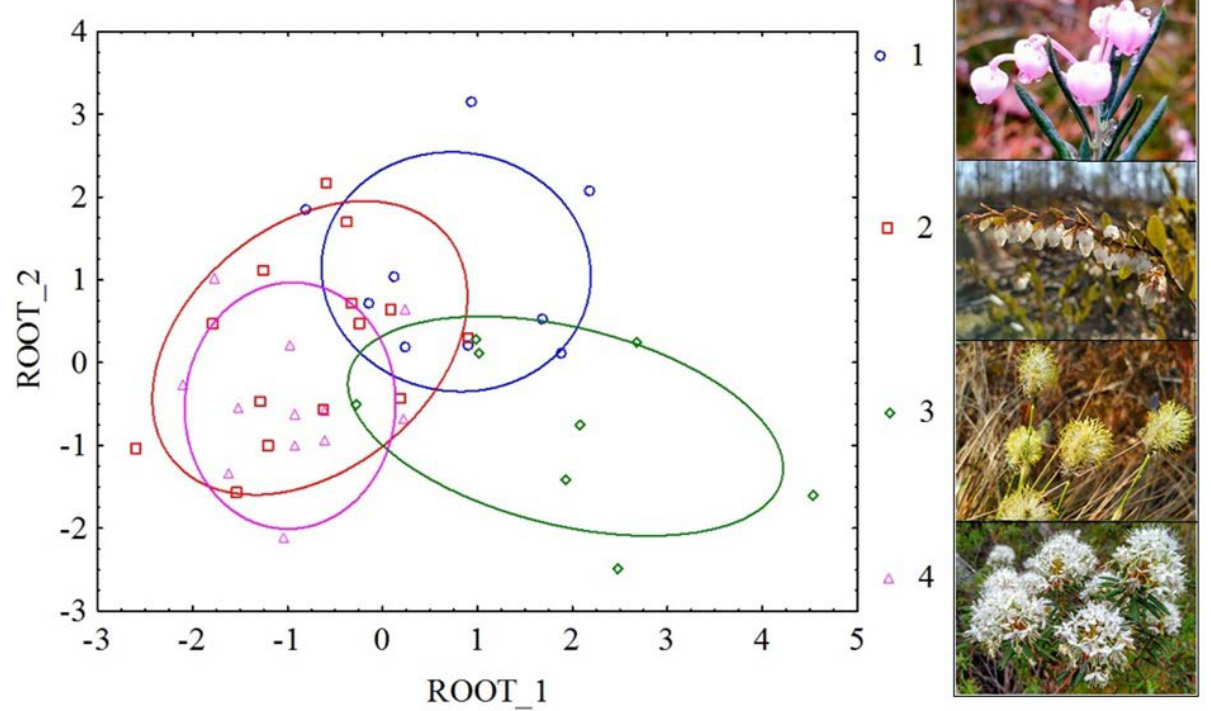
Figure 5. Differences between plant species (1: Andromeda polifolia ; 2: Chamaedaphne calyculata ; 3: Eriophorum vaginatum ; 4: Rhododendron tomentosum ) in the accumulation of Zn, Cu, Pb and